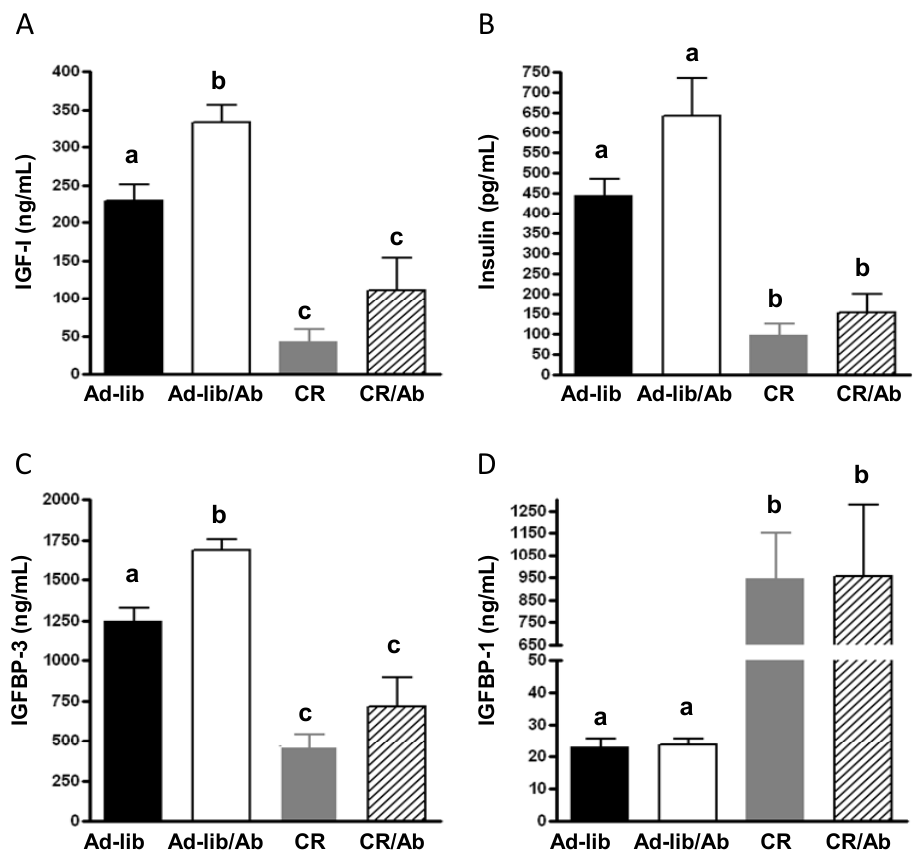
Figure 4. Effect of the intervention on the IGF axis. Fasting plasma concentration of ( A ) IGF-1; ( B ) Insulin I; ( C ) GFBP-3; and ( D ) IGFBP-1 from SCID mice on the different therapy regimen. Plasma IGF-1, IGFBP-1, IGFBP-3 and insulin levels were assessed using ELISA in 6 to 8 animals per group. Values are means ± standard errors (SE). Means with different letters are significantly different from each other ( p < 0.05, one way analysis of